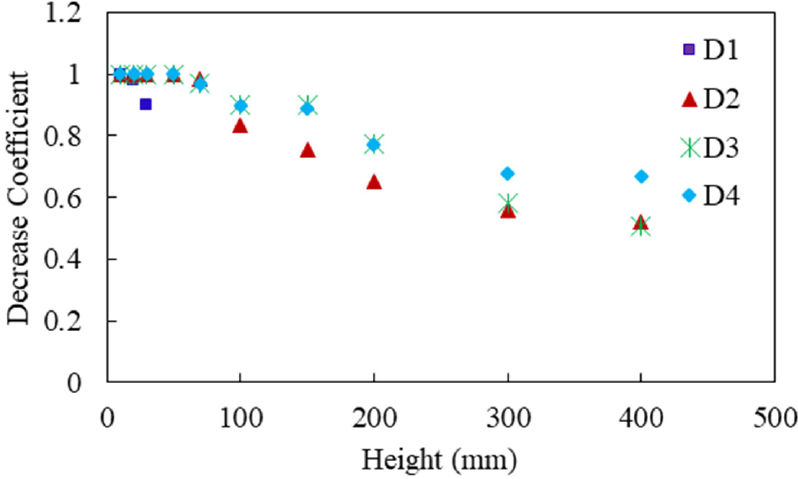
Figure 16. Estimated decrease coefficients of D1, D2, D3, and D4 slabs. The analytical results of impact force histories based on the spring-mass model are compared with experimental results in Figure 17 for verification. The results reveal the magnitude of the peak impact force, but with a time shift due to the assumptions made dur- ing the analytical modelling. This also indicates that the decrease coefficients or specimen stiffness should be accounted for when the repeated impact tests are carried